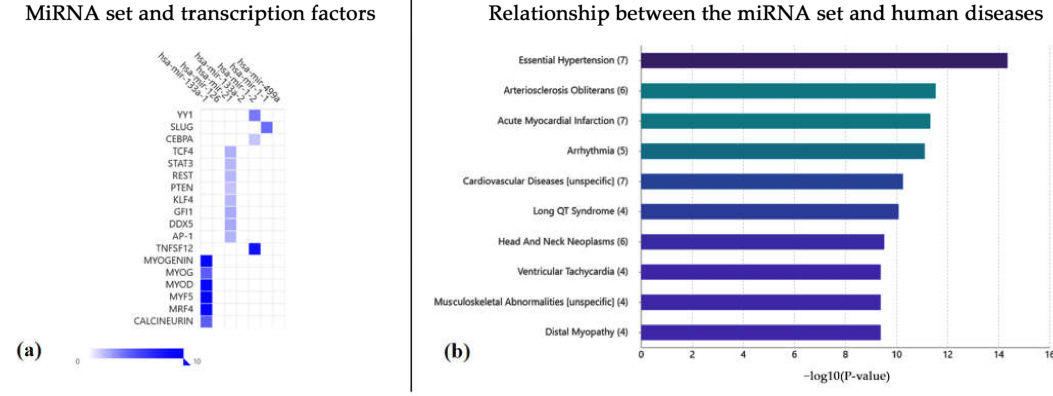
Figure 4. ( a ) Summary of the plot of the miRNA set and the transcriptional factors influenced by their molecular actions. ( b ) Summary of the main diseases correlated with this miRNA dataset.